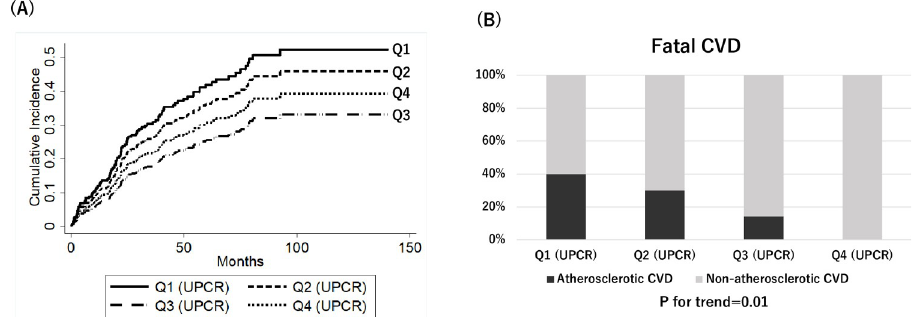
Fig 3. Cumulative incidence of atherosclerotic CVD after dialysis initiation (A) and percentages of atherosclerotic CVD to total fatal CVD by UPCR quartile. Patients in UPCR Q1 have a significantly higher risk for atherosclerotic CVD than patients in UPCR Q3 (subhazard ratio [95% confidence interval]: 1.84 [1.06–3.17]). Abbreviations: CVD, cardiovascular disease; Q1-4, quartiles 1–4; UPCR, urine protein-to-creatinine